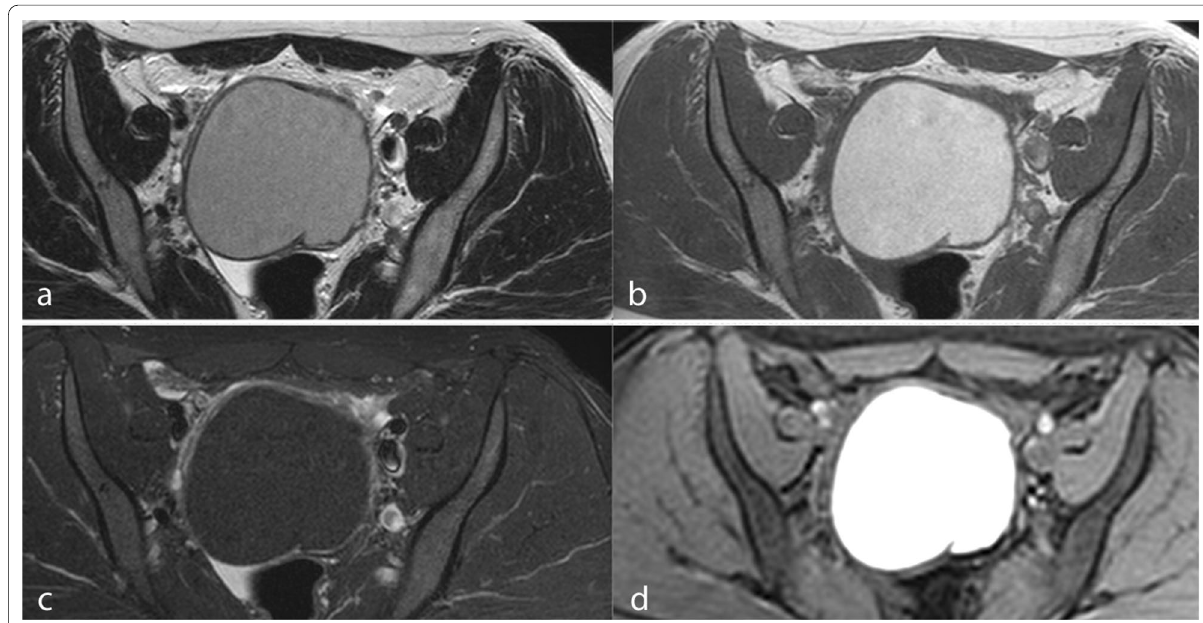
Fig. 2 OMA mimicking a mature cystic teratoma in a STIR sequence. ( a ) TSE T2w axial image, ( b ) TSE T1w axial image, ( c ) STIR axial image and ( d ) THRIVE axial image. The loss of T1w high signal intensity in the STIR image is not specific to fat ( c ), because endometriomas and fatty tissue may have similar T1 relaxation times. In the THRIVE sequence, on the basis of a spectral saturation of fat, the endometrioma remains hyperintense ( d )